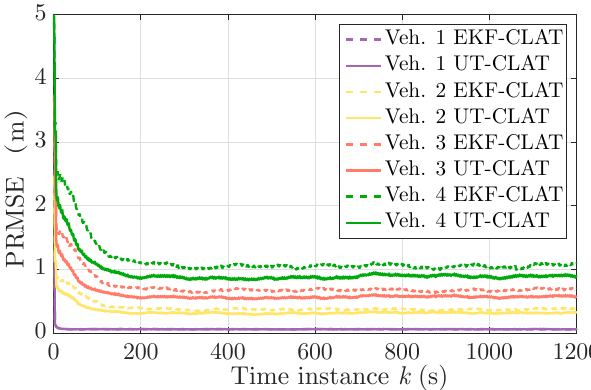
Figure 7. Self-localization estimation position root-mean-square errors (PRMSEs) of the unscented transformation-based collaborative self-localization and target tracking scheme (UT-CLAT) vs. the extended Kalman filter-based CLAT (EKF-CLAT) for robots